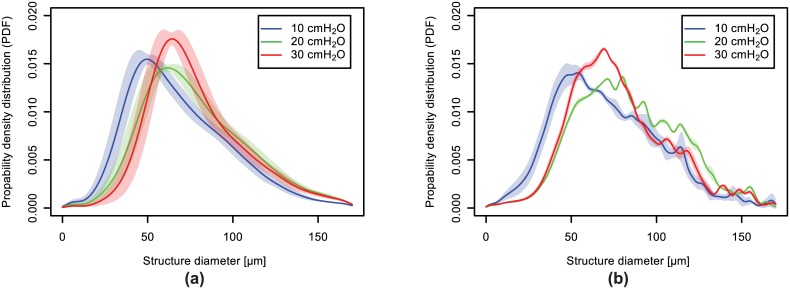
Local air volume thickness PDF.Probability density functions (PDF) of the local air volume thicknesses for the two different optics: (a) shows the air volume thickness-map PDF for the 2.9 μm-pixel-size optics; (b) shows the one for the 1.1 μm-pixel-size optics. The uncertainty intervals arise from the different sets of segmentations.